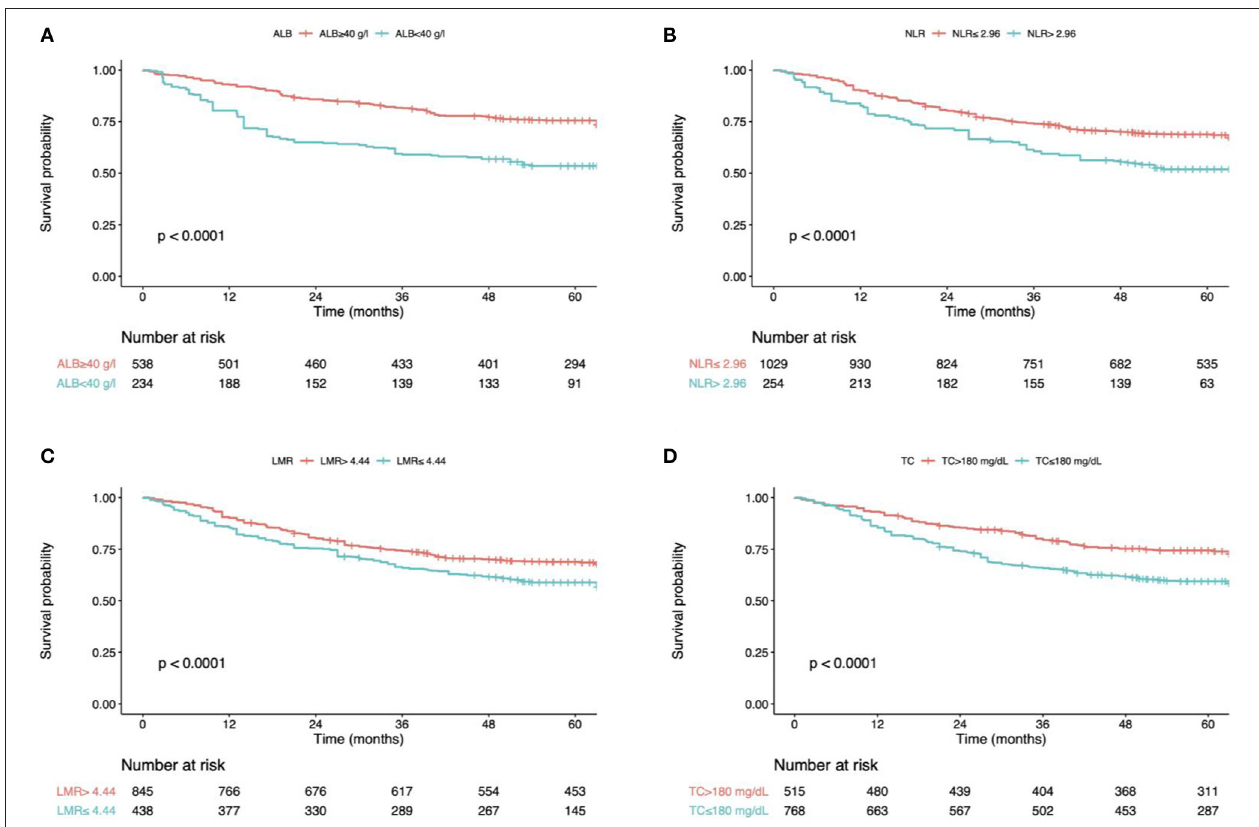
FIGURE 3 | (A) overall survival curves according to the preoperative ALB. (B) overall survival curves according to the preoperative NLR. (C) overall survival curves according to the preoperative LMR. (D) overall survival curves according to the preoperative TC. ALB, albumin; TC, total cholesterol; NLR, neutrophil-to-lymphocyte ratio; LMR, lymphocyte-to-monocyte